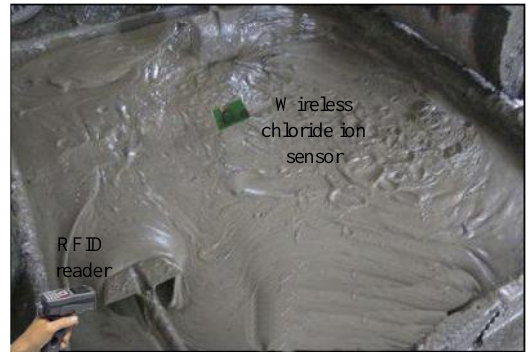
Figure 9. Test environment.